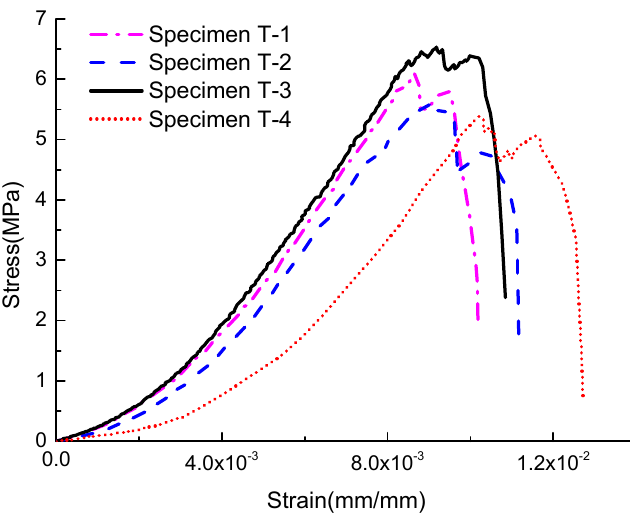
Figure 10. Relationship between elastic strain energy density and total input strain energy density for TJH coal mine.